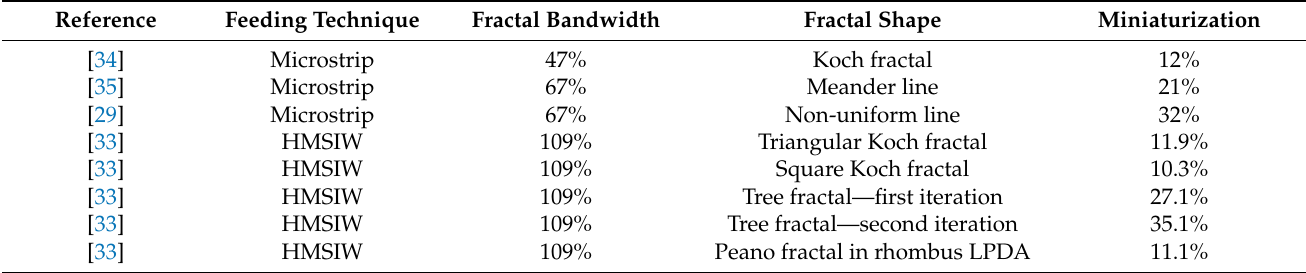
Table 1. Comparison of PLPDAs with different fractal